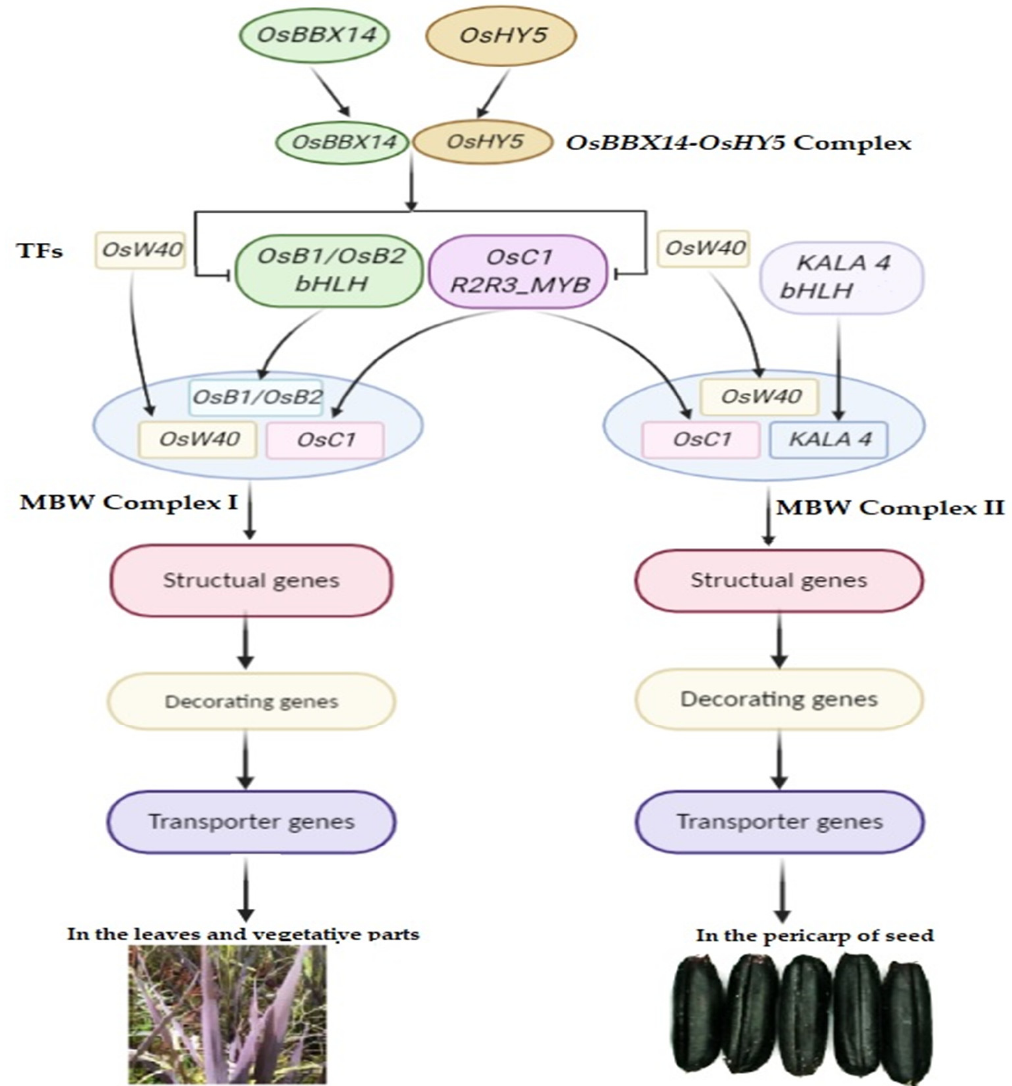
Figure 5. Regulatory mechanism and transcriptional factor interactions in black rice.